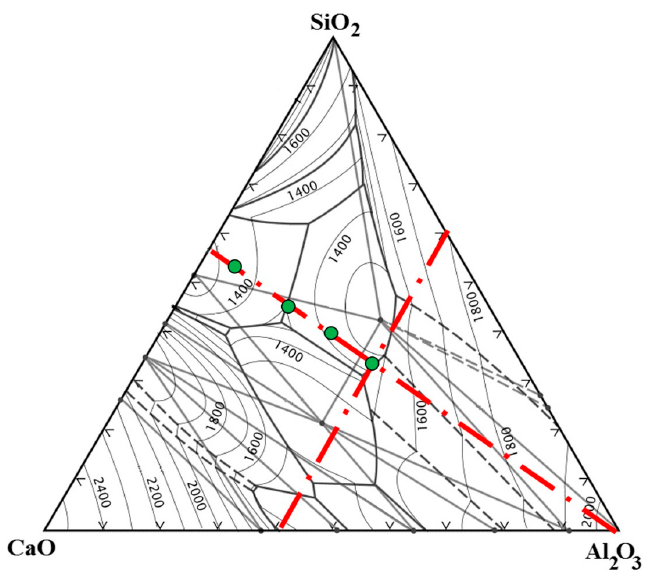
Figure 1. CaO–SiO 2 –Al 2 O 3 ternary phase diagram [12].